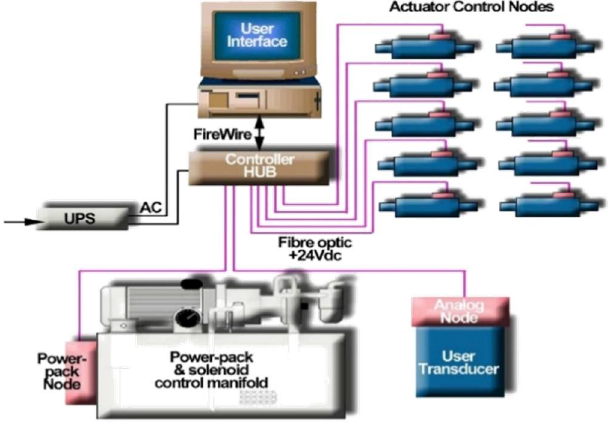
Figure 6. The loading